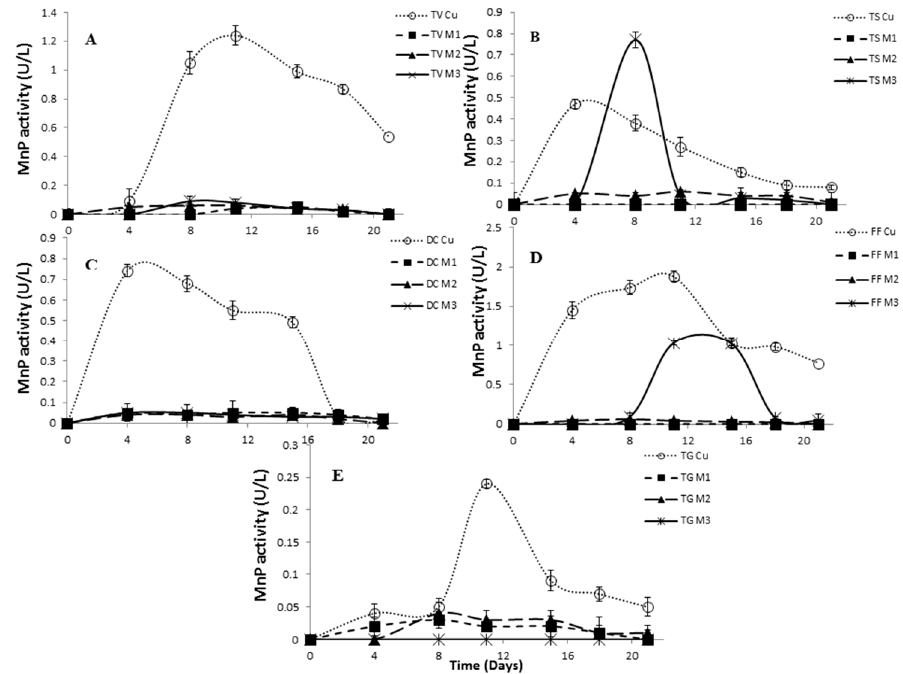
Figure 6. Evaluation of manganese-dependent peroxidase activity of TV, Trametes versicolor ( A ); TS, Trametes suaveolens ( B ); DC, Daedaleopsis confragosa ( C ); FF, Fomes fomentarius ( D ); and TG, Trametes gibbosa ( E ), with a 0.5 mM concentration of inducers. Standard deviation lines represent the variation of mean activity value obtained from three replicate cultivations.